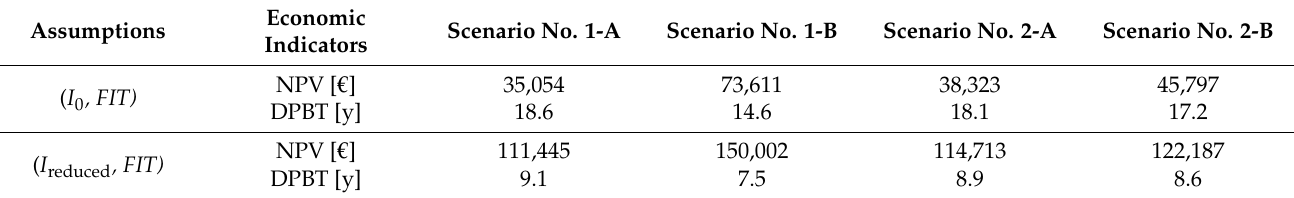
Table 5. Summary of NPV and DPBT values for the investigated